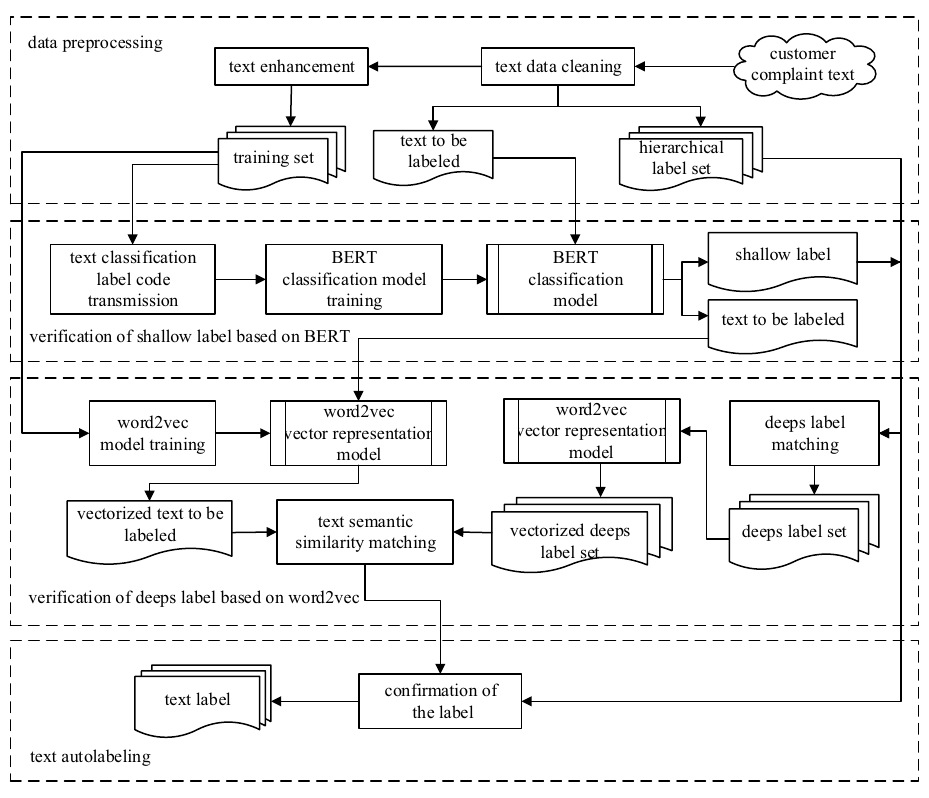
Figure 2. BERT and word2vec-based automatic text labeling model for customer